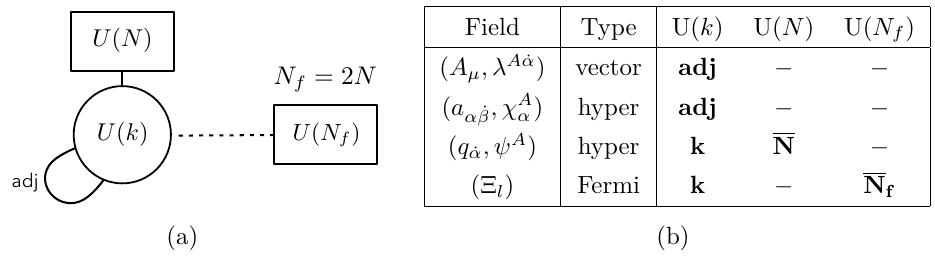
Figure 2. UV gauge theory on SU( N ) self-dual strings in the M-string Higgsing chain. (SU(2) , SU(2) , SU(2) ) symmetry by ( α, ˙ α, A ) . 32 supercharges of type IIA string r R l